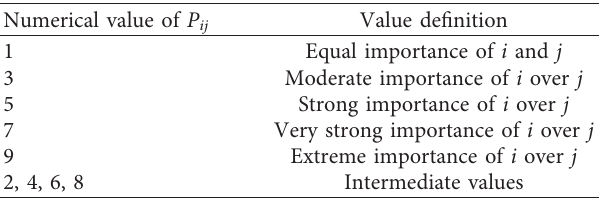
Table 2: Analytical hierarchy process evaluation